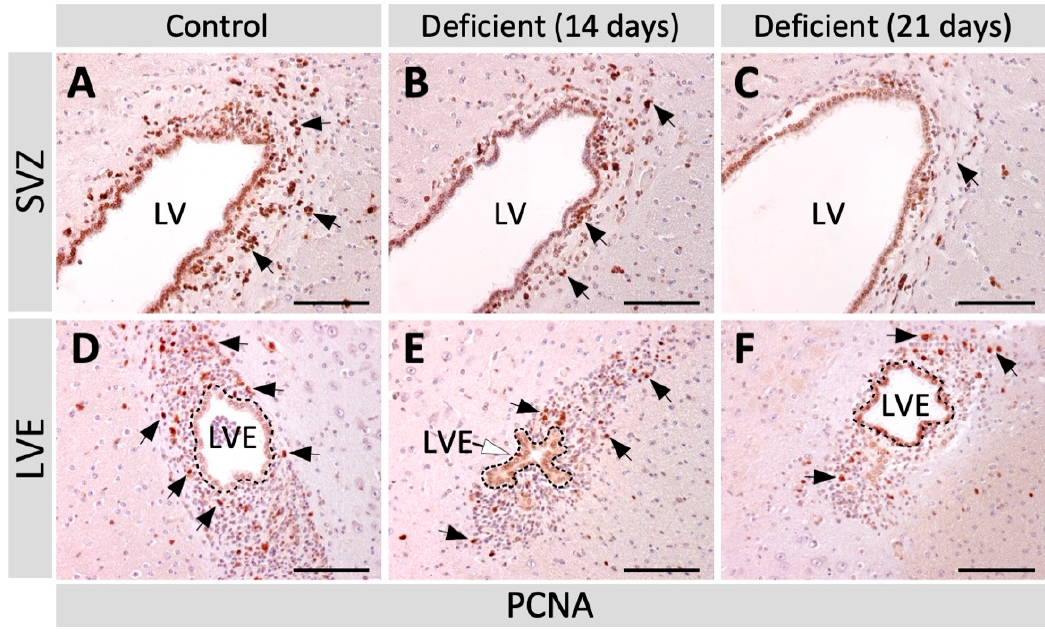
Figure 2. Analysis of PCNA-positive cells (B-type and C-type cells) in the brain of adult vitamin-C-deficient guinea pigs. Coronal sections of the brain of control guinea pigs ( A , D ) and the brain of guinea pigs with 14 ( B , E ) and 21 days ( C , F ) of vitamin C deficiency, labeled with anti-PCNA (1:100) as a proliferation marker. In the SVZ ( A – C ), PCNA-positive cells (arrows) progressively decreased with increasing days of vitamin C deficiency. In the LVE ( D – F ), PCNA-positive cells (arrows) decreased in vitamin-C-deficient animals ( E , F ). LVE: lateral ventricle extension. LV: lateral ventricle. SVZ: subventricular zone. n = 4. Scale bar: 100 µ